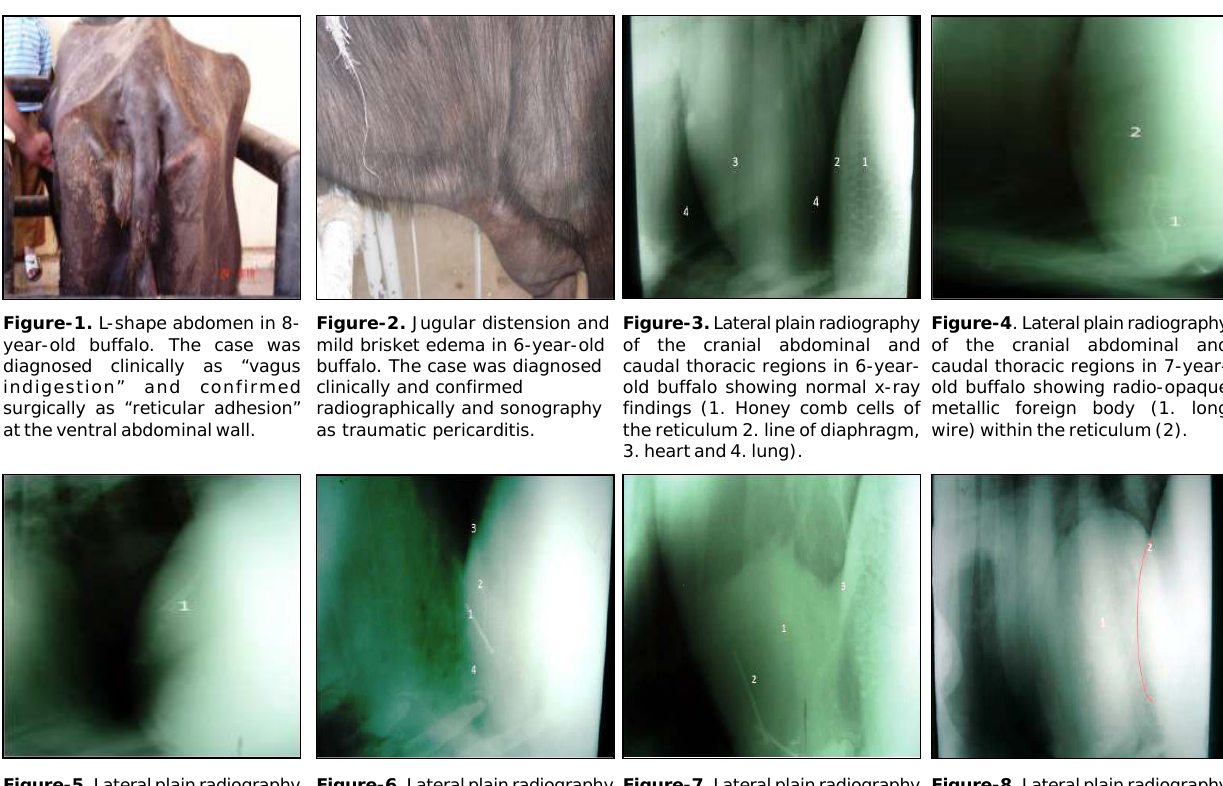
Figure-5. Lateral plain radiography of the cranial abdominal and caudal thoracic regions in 5-year- old buffalo showing radio-opaque metallic foreign bodies (1. nails) at the diaphragmatic surface of the reticulum.